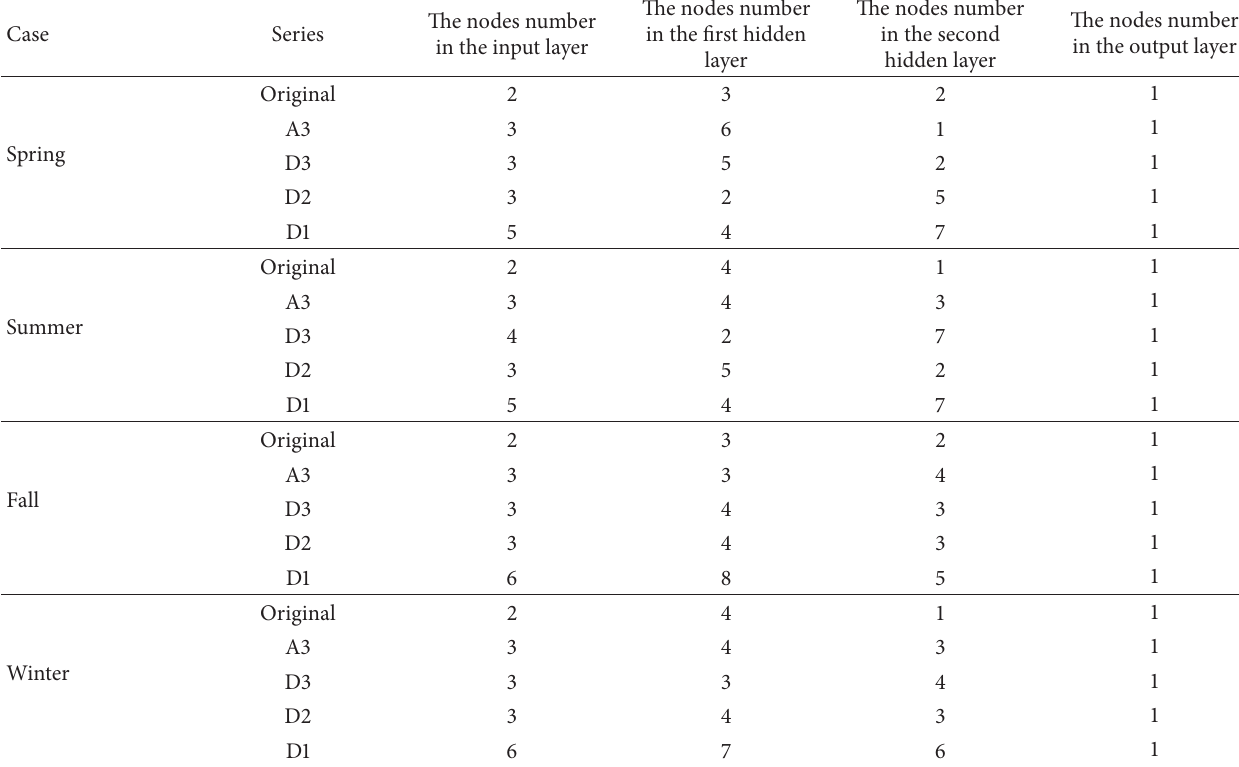
Table 4: The optimal network structure of all the original series and subseries.